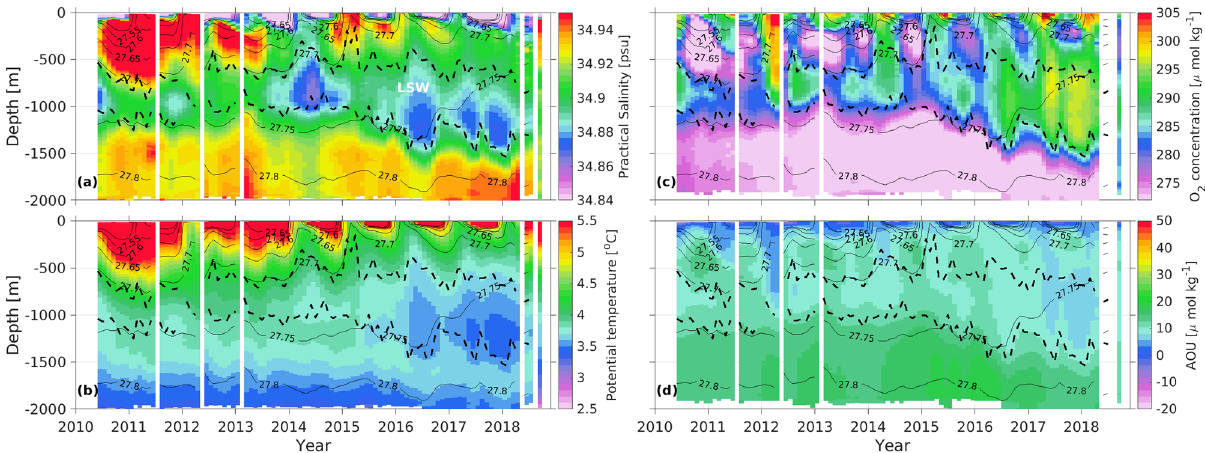
Fig. 4 Temporal variability of the water properties in the Irminger Sea from Argo data. Variability between 2010 and 2018 of a salinity (psu), b potential temperature θ ( ∘ C), c oxygen concentration ( μ mol kg − 1 ), and d Apparent Oxygen Utilization AOU ( μ mol kg − 1 ) computed from Argo data in the Irminger Sea. The dashed black contours highlight the lower and upper boundaries of the Labrador Sea Water (LSW) layer. Note that the vertical white lines indicate missing data for